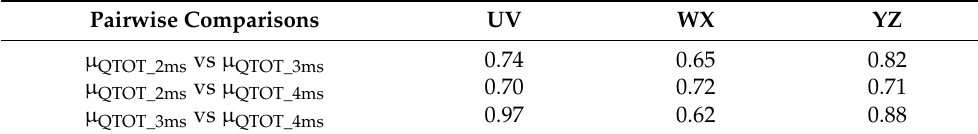
Table 8. Two sample t -test calculated p -value